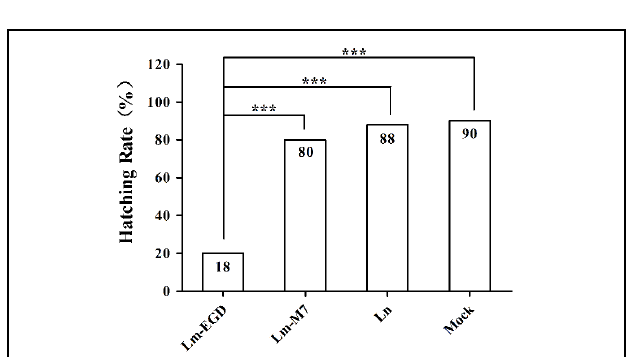
divided into 10 subgroups, each having five fish larvae to be homogenized and resuspended in 100 μ l of PBS, from which a volume of 10- μ l suspension was spotted in triplicate on the PALCAM agar plates for bacterial enumeration. Data were expressed as log 10 CFU per five fish.